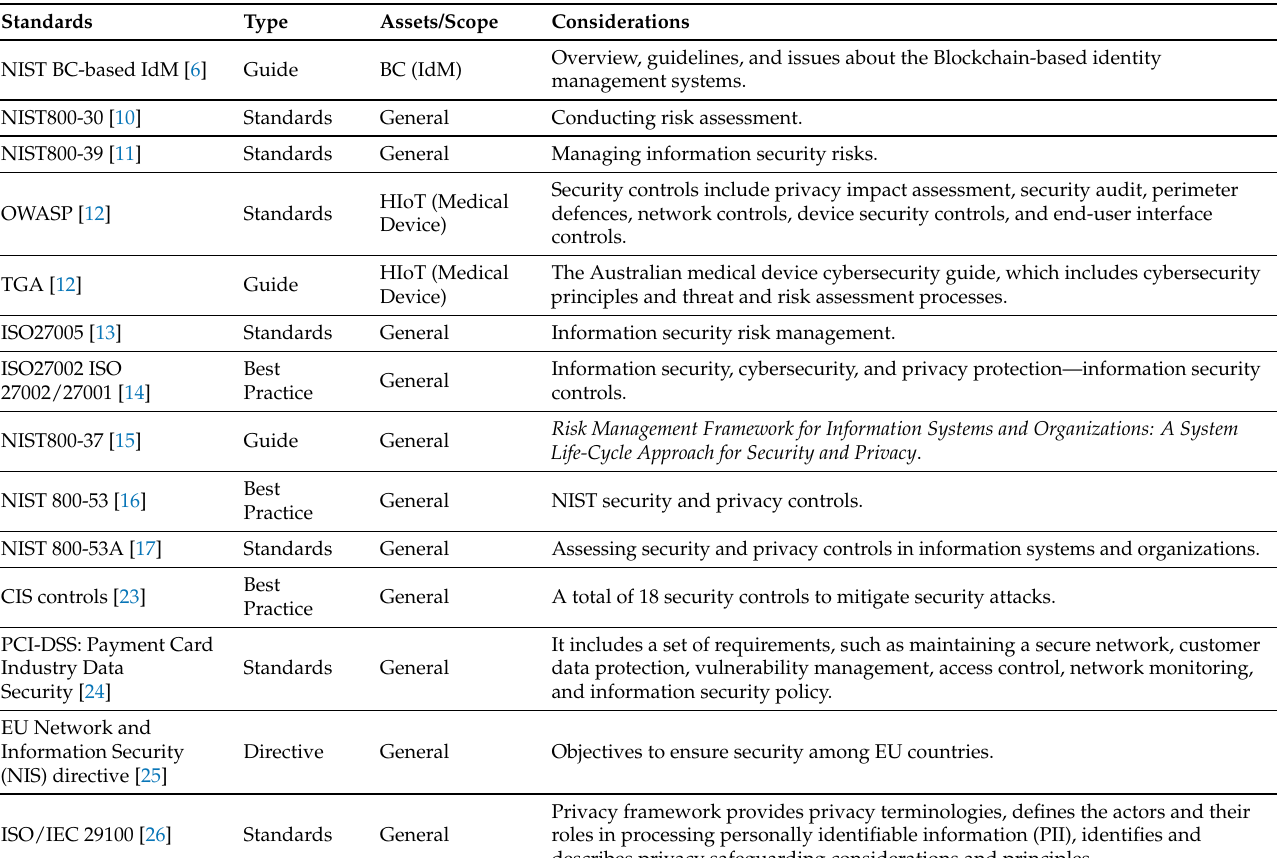
Table 8. The identified standards relating to HIoT, BC, and IdM